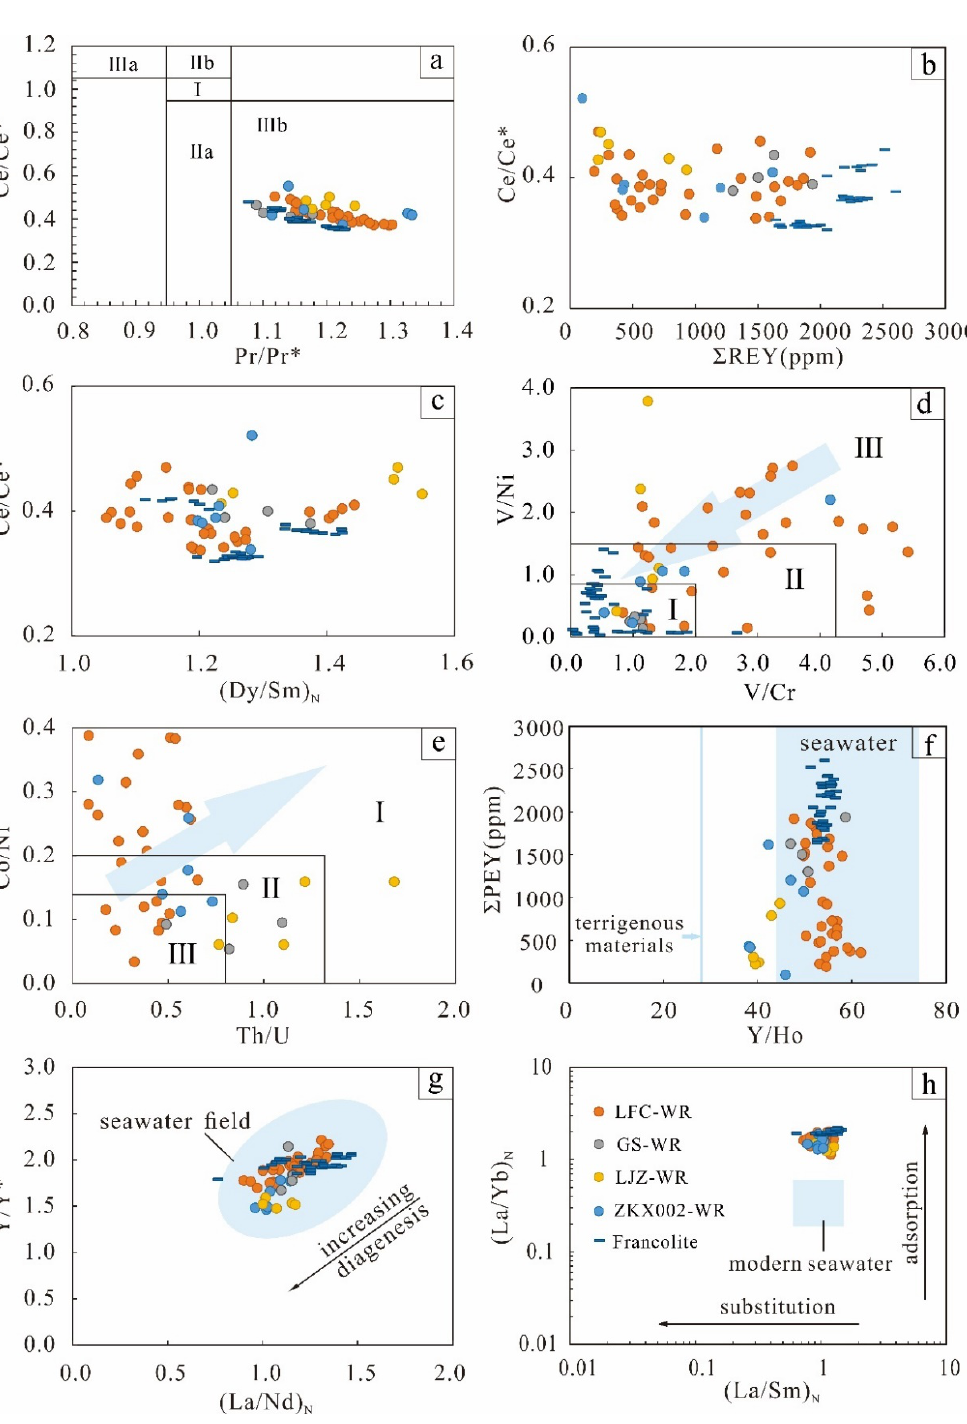
Figure 9. REE plots: ( a ) position of the data points in bivariate plot of Pr/Pr*-Ce/Ce*, modified after Bau and Dulski, 1996 [69]. The five fields are defined as follows: I: no La and Ce anomaly; IIa: positive La anomaly and no Ce anomaly; IIb: negative La anomaly and no Ce anomaly; IIIa: positive Ce anomaly; IIIb: negative Ce anomaly. ( b ) Ce/Ce*- Σ REY diagram based on Morad and Felitsyn (2001) [68] and Shields and Stille (2001) [33]. ( c ) Ce/Ce*– Dy N /Sm N diagram based on Morad and Felitsyn (2001) and Shields and Stille (2001). ( d , e ) V/Cr-V/Ni and Th/U-Co/Ni diagram of phosphorite and francolite samples from Zhijin deposit. Modified after Ross and Bustin (2006) [70] and Zhang et al. (2021) [29]. Legend: I: oxic environment, II: suboxic environment, III: anoxic environment. The arrow indicates the direction of oxic environment. ( f ) Y/Ho ratios of samples